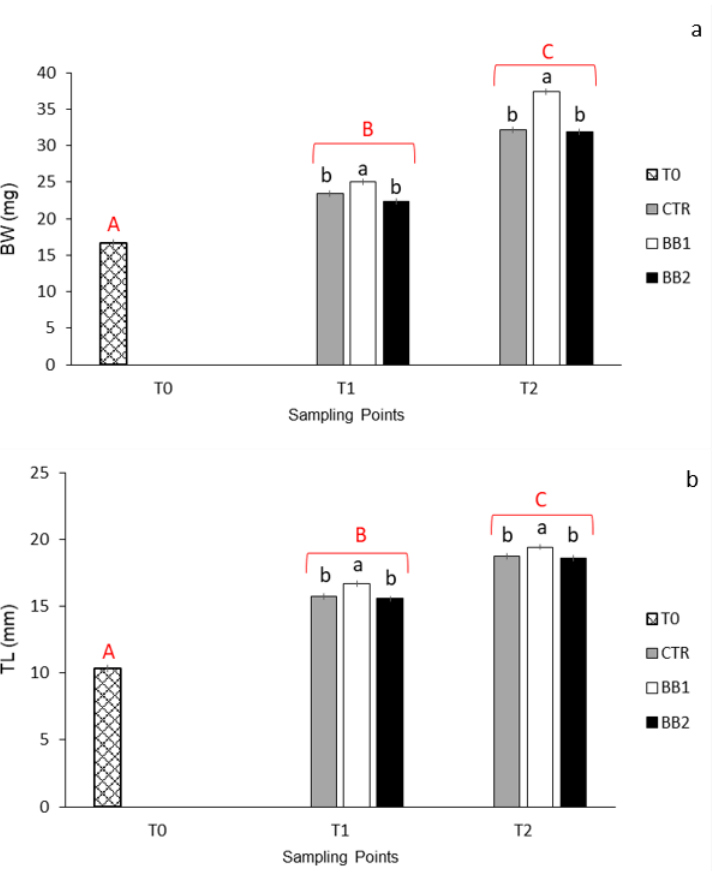
Figure 2. ( a ) Larval growth expressed in mg of BW; ( b ) Larval length expressed in mm of TL; error bars indicate the standard error of the mean for each treatment/stage of development; a,b Means with different superscripts differ significantly between treatments (black font) or stages of development (red font) ( p < 0.05); A,B,C Means with different superscripts differ significantly between treatments (black font) or stages of development (red font) ( p < 0.01).